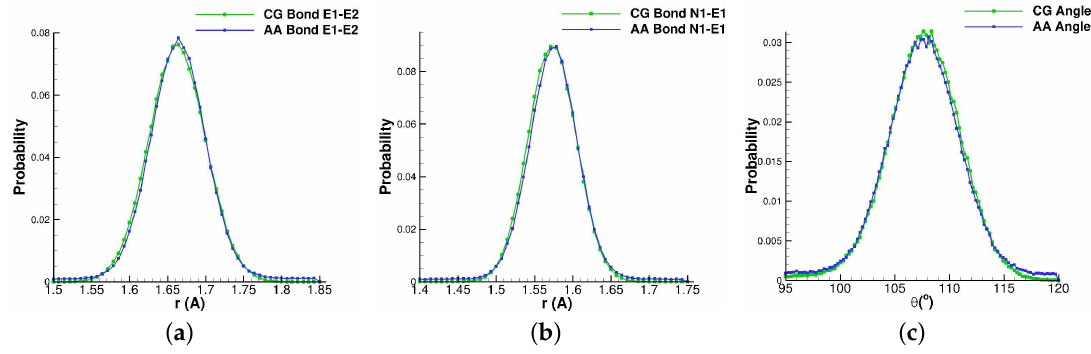
Figure 3. Probability distribution comparison of the sampled bond distance and angle data from the all-atom (AA) and coarse-grained (CG) MD simulations. ( a ) Bond distance E1-E2 from the coarse-grained model; ( b ) Bond distance E2-N1 from the coarse-grained model; ( c ) Angle N1-E1-E2 from the coarse-grained